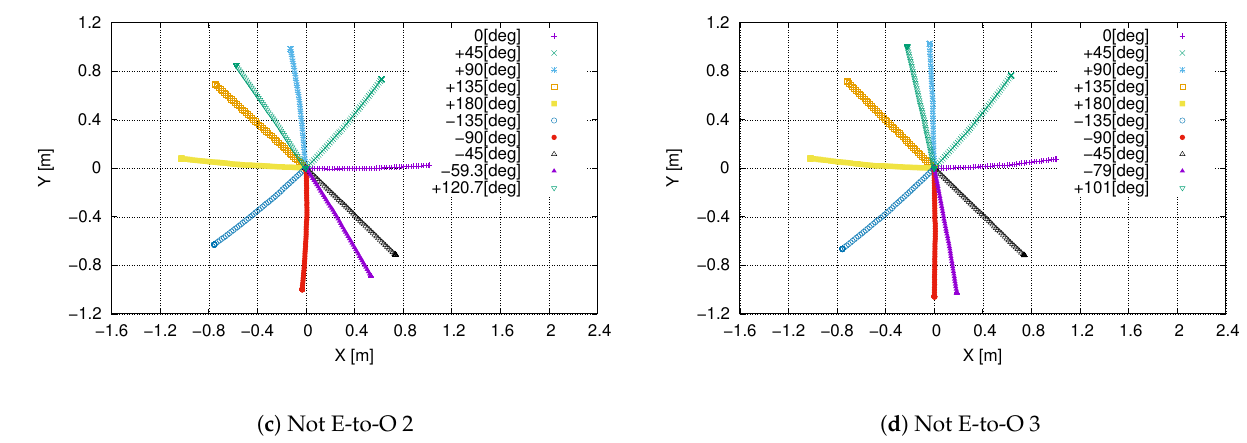
Figure 7. The robot trajectory during each travel direction with 4-wheeled Omni wheel robots.